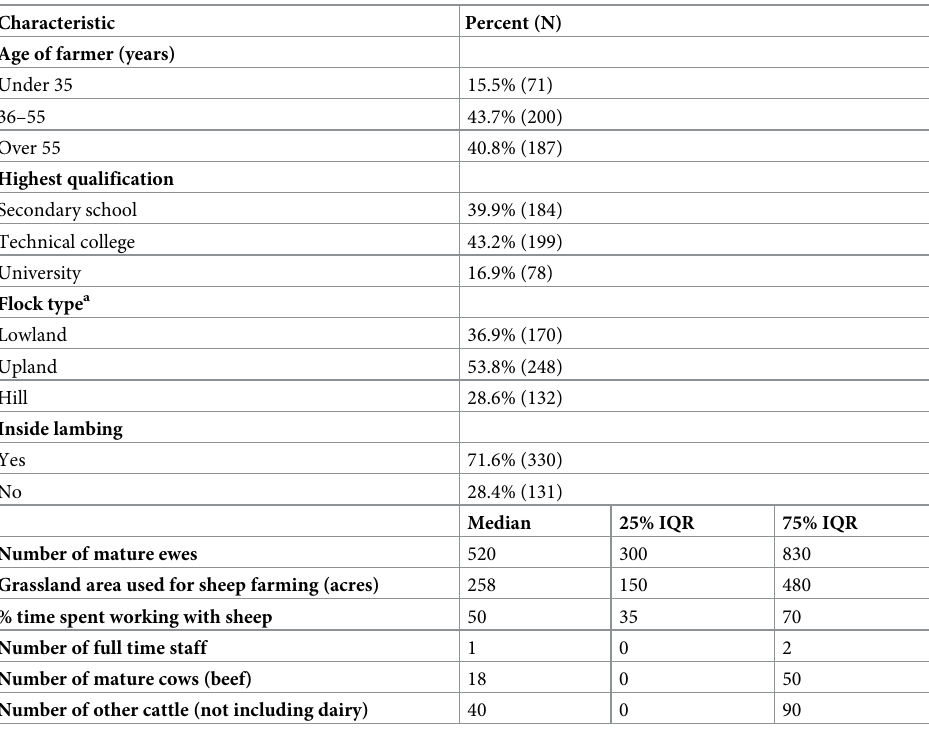
Table 1. Characteristics of the respondents and their